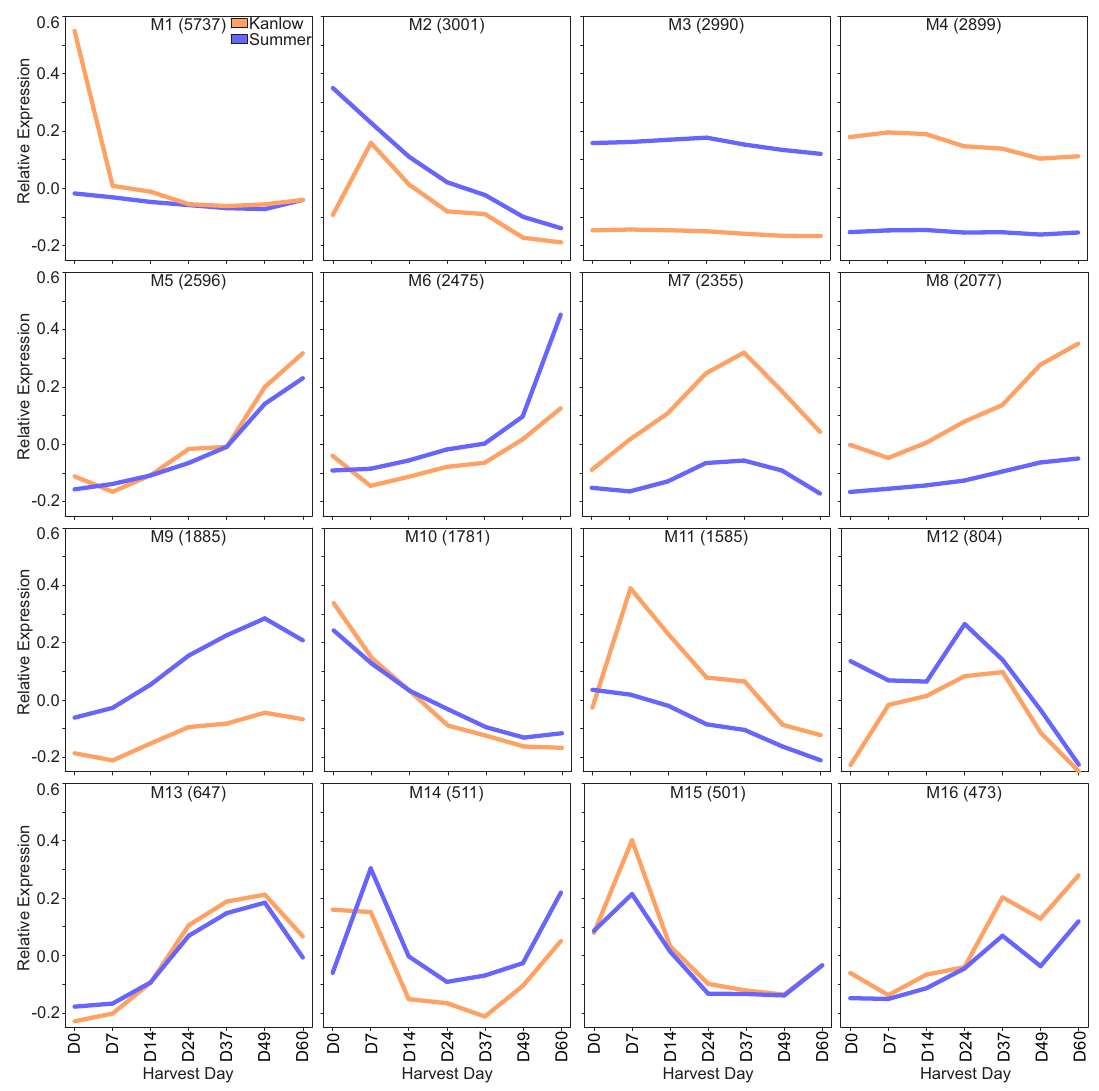
Fig 5. Leaf gene co-expression modules. Kanlow (orange lines) and Summer (blue lines) over the time course of the experiment. In each panel, relative expression (based on module eigengenes) is on the Y-axis and harvest times on the X-axis. Total numbers of genes in each module are indicated in